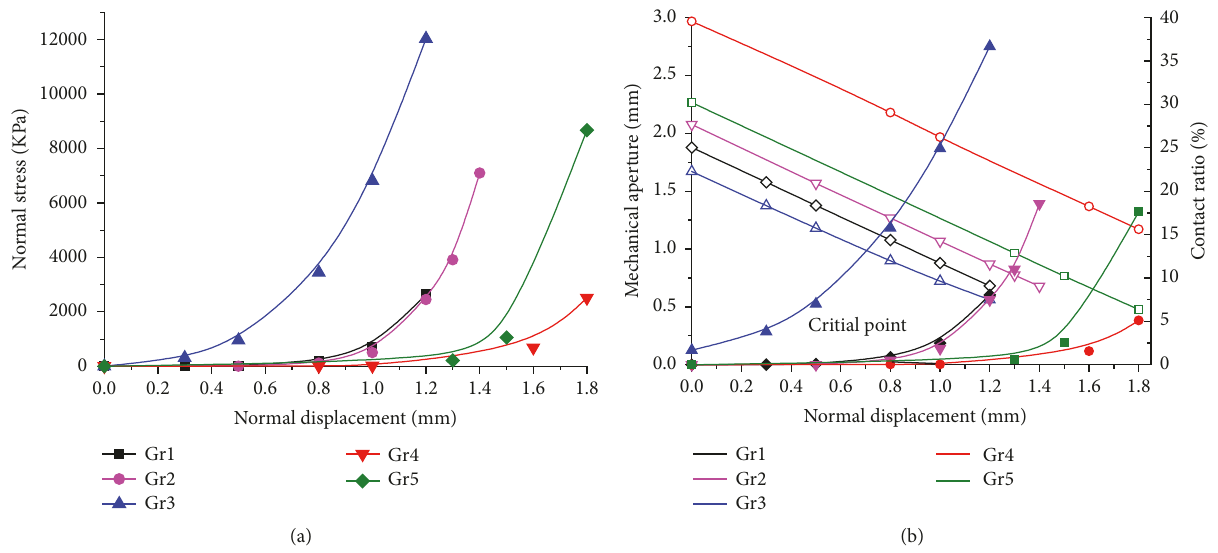
Figure 5: (a) Normal displacement against normal stress. (b) The change of fracture geometry during normal loading (solid points represent mechanical aperture and open points represent contact